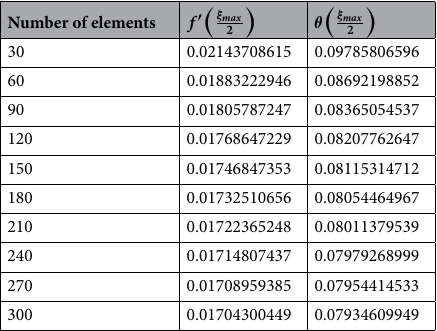
Table 2. Mesh free investigation of temperature and velocity at mid of each 300 elements.